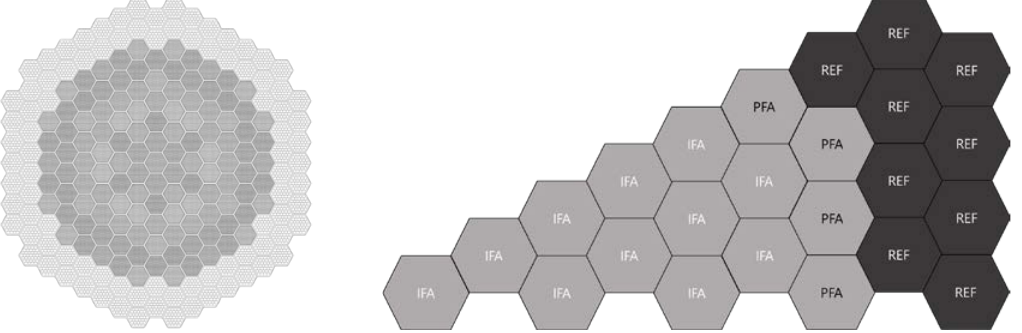
Figure 2. Two-dimensional Simplified Prototype Gen- Ⅳ Sodium-cooled Fast Reactor (sPGSFR) Benchmark Problem. (IFA: interior FA, PFA: peripheral FA, REF: reflector)